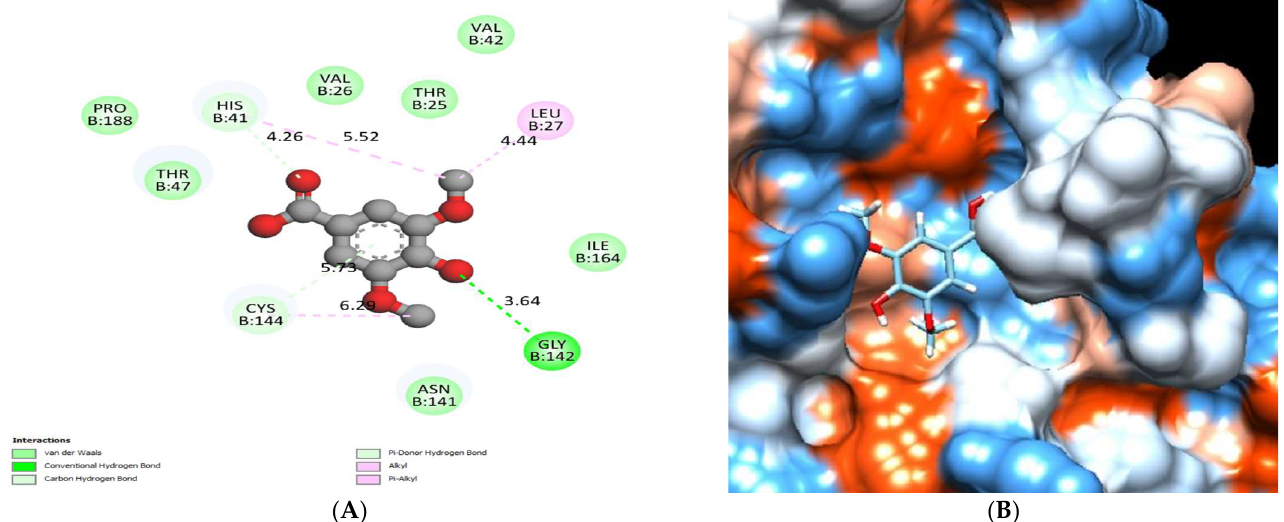
Figure 15. Syringic acid docked in HCo-V 229E main protease. Hydrogen bonds are represented in green and pi interactions are described in pink lines ( A ), with a mapping surface showing syringic acid occupying the active pocket of HCo-V 229E main protease ( B